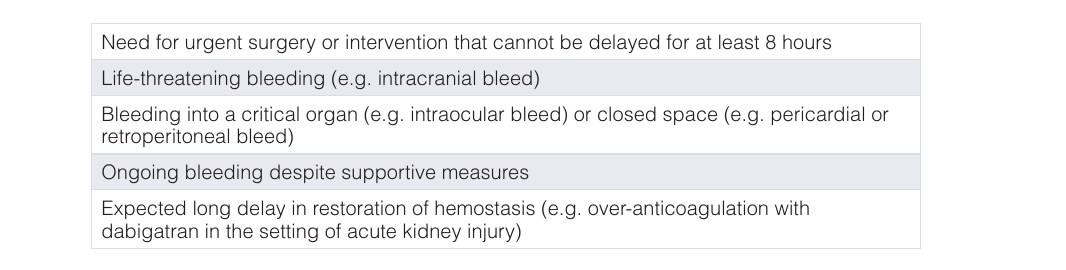
Table 5. Indications for reversal of direct oral anticoagulants.